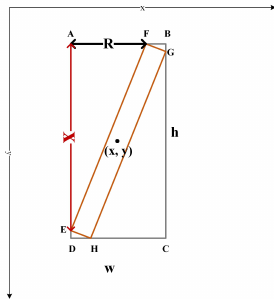
Figure 4. Schematic diagram of the rectangle in the coordinate axis. ( x , y , w , h , R , X ) are known, and vertex coordinates (A, B, C, D, E, F, G, H) are